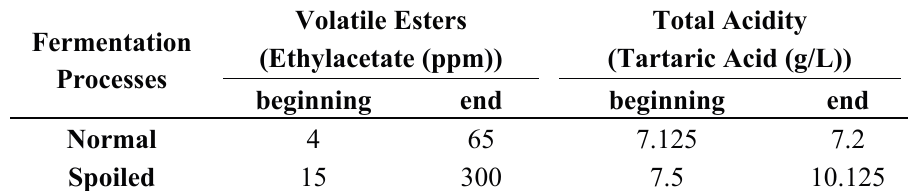
Table 1. Concentrations of characteristic components of the fermented musts at the beginning and at the end of the fermentation